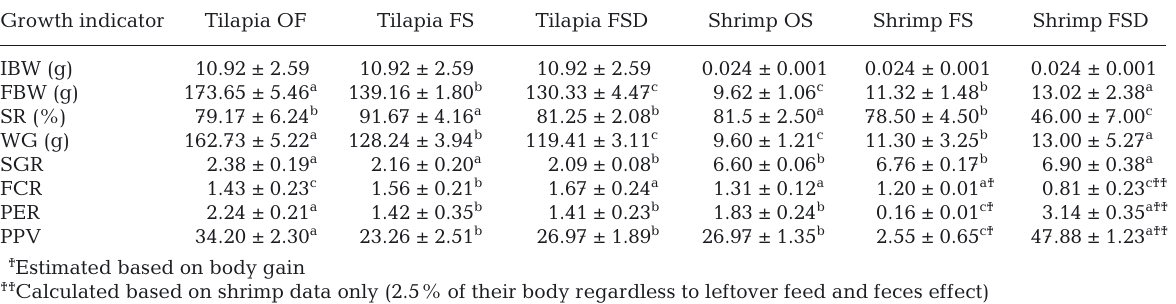
Table 3. Growth performance for red Nile tilapia Oreochromis niloticus and whiteleg shrimp Litopenaeus vannamei culture in either monoculture or co-culture systems (see Table 1 for treatments). Values are mean ± SD. Values with different super- scripts in the same rows (same species) are significantly different from the monoculture treatment (p ≤ 0.05). IBW: initial body weight; FBW: final body weight; SR: survival rate; WG: weight gain; SGR: specific growth rate; FCR: feed conversion ratio; PER: protein efficiency ratio; PPV: protein productive value (see Eqs. 1−7 in the main text for calculations of the growth